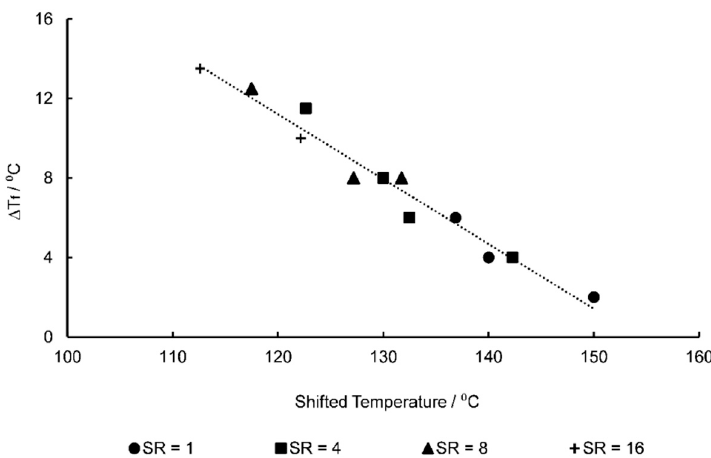
Figure 12. ∆ T f against shifted temperature following use of time-temperature superposition.